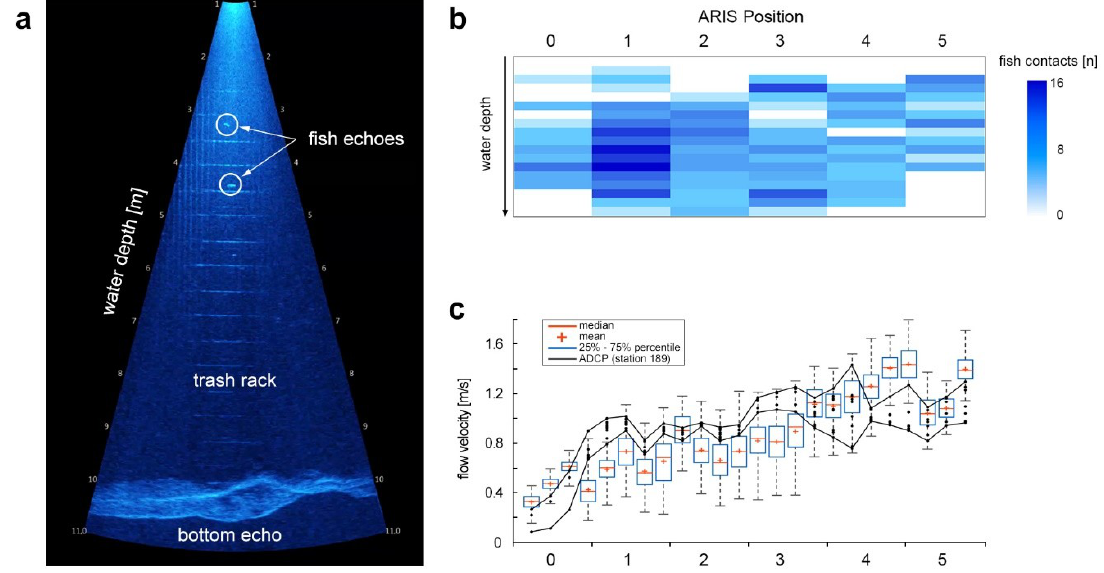
Figure 9. ( a ) Two fish echoes at the trash rack (video frame from the ARISFish software). ( b ) Cumulative plot of fish contacts (in depth steps of 0.5 m water column) in front of the trash rack (based on 3 h of vertically recorded sonar data in the period 05–07 April 2017) and ( c ) Plot of ADCP (black lines form lower and upper bounds) and DBox calibration data as box plots.